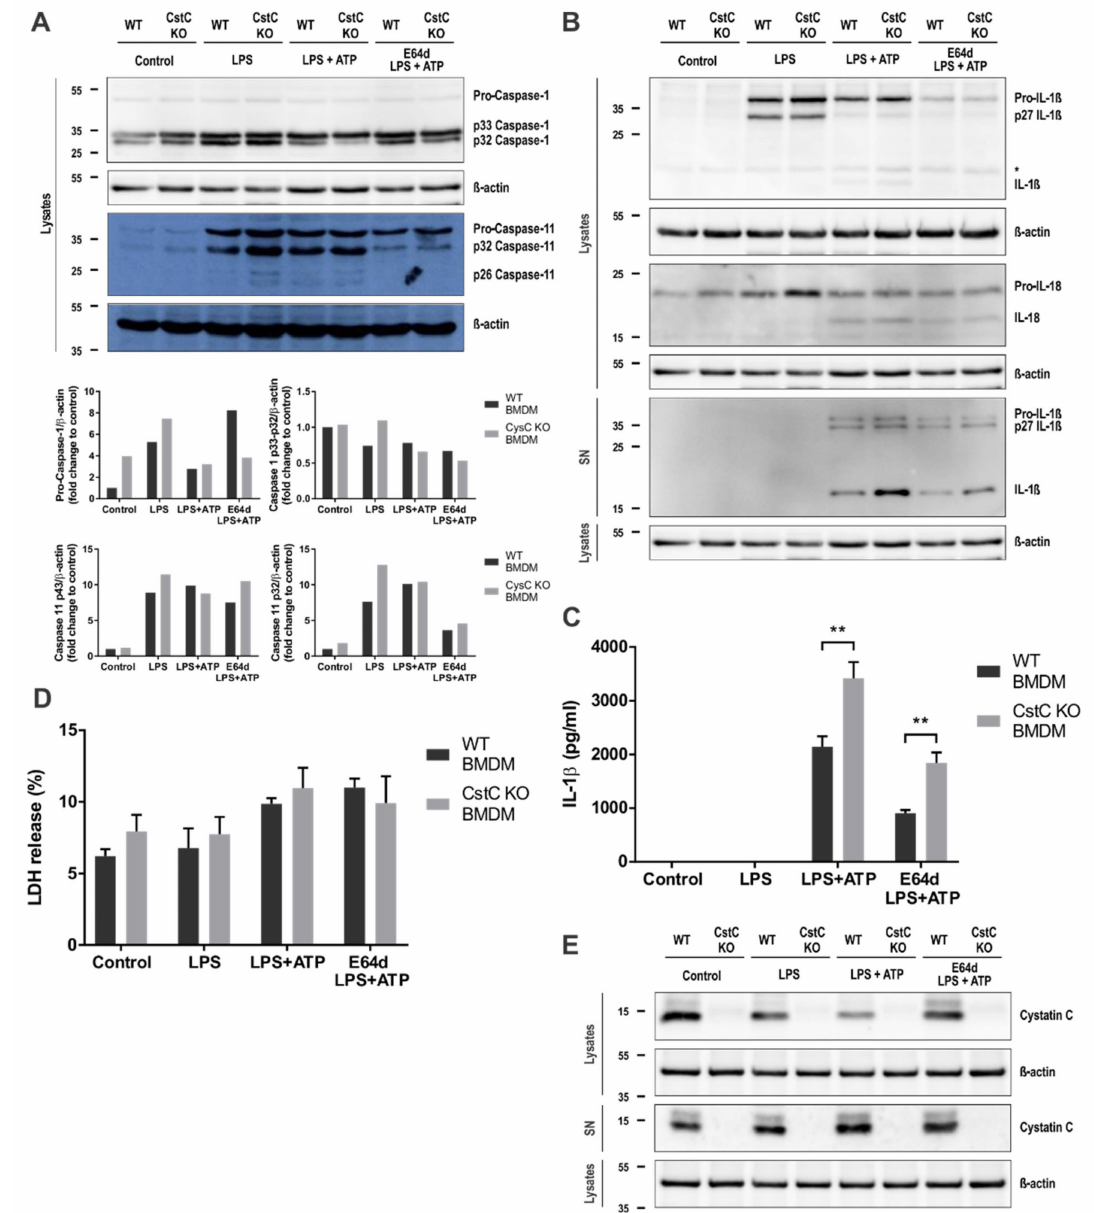
Figure 3. Increased activation of NLPR3 inflammasome in CstC KO BMDMs is independent of increased cysteine cathepsin activity. BMDMs were pre-treated for 2 h with E-64d (20 µ M), primed for 4 h with LPS (100 ng/mL) and stimulated for 20 min with ATP (5 mM), as indicated. ( A ) and ( B ) Cell lysates were immunoblotted with indicated antibodies. Supernatants were precipitated and immunoblotted with indicated antibodies. ( C ) BMDMs were plated on 96-well plates and stimulated as described above. Supernatants were collected and IL-1 β release was measured with enzyme-linked immunosorbent assay (ELISA). ( D ) Viability of BMDMs was assessed by LDH release into the cell culture media. The cytotoxicity was expressed as the percentage of the total LDH release. ( E ) Cell lysates were immunoblotted with indicated antibodies. Data shown are cropped blot images, representative of three independent experiments. Data were obtained from three independent experiments performed in triplicate, and the results are presented as means ± S.D. * p < 0.05; ** p <